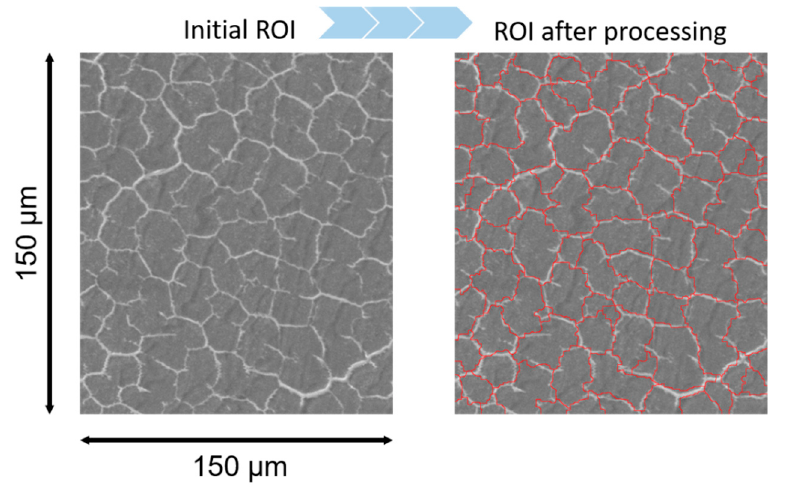
Figure 3. The result of applying the image processing technique for the SEM image of SRC by the ImageJ software.